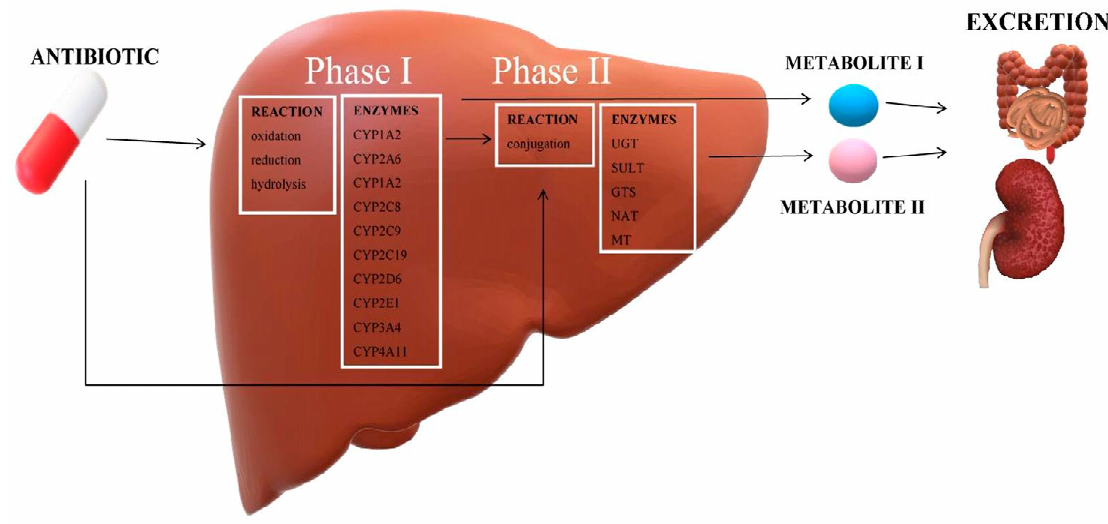
Figure 2. The concept of antibiotics’ metabolism in the liver.